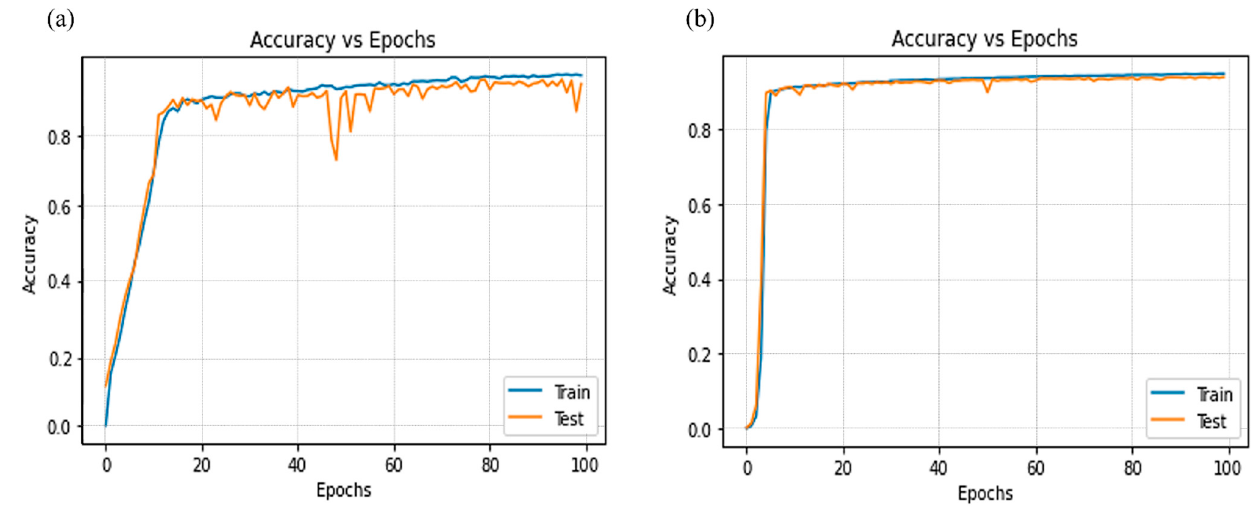
Figure 8. Results of training in 91 patients with mixed LiTS and KCGMH: ( a ) liver and ( b )